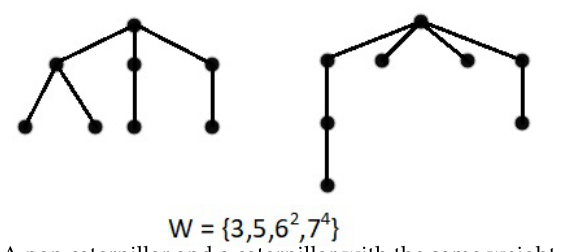
Figure 4. A non caterpillar and a caterpillar with the same weight sequence.